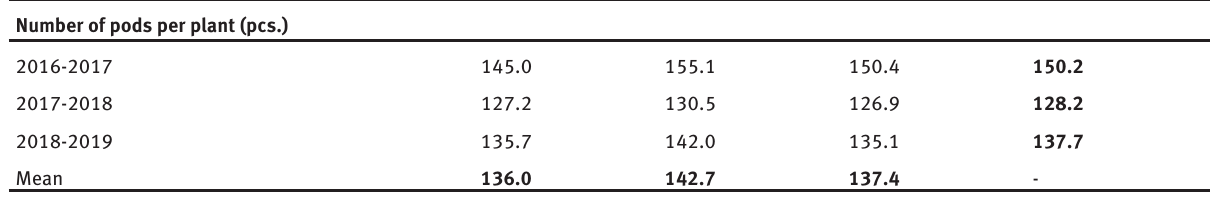
Number of pods per plant (pcs.)